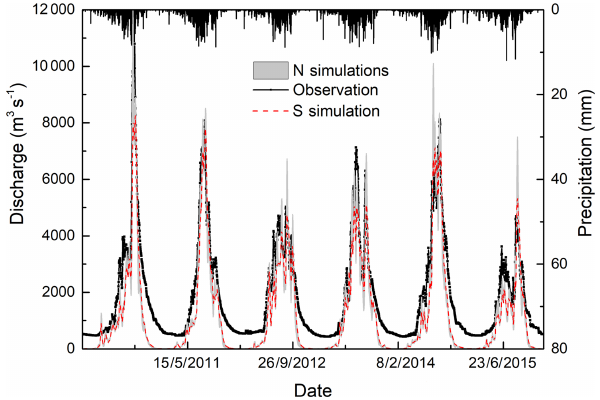
Figure 3. Daily time series of simulated and observed streamflow at Nuxia station. The upper bar is the areal